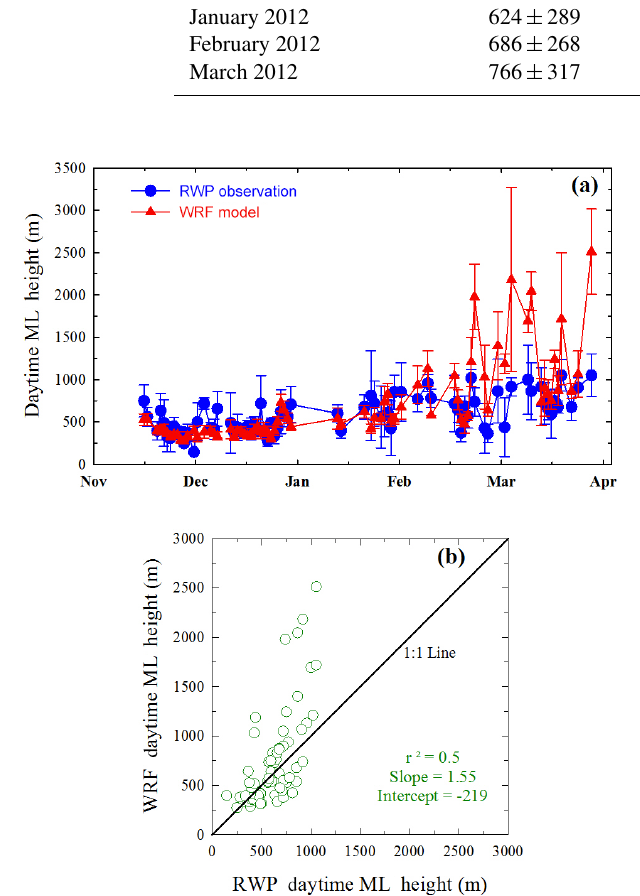
Figure 7. (a) A comparison of daytime (05:00–10:00UTC) average boundary layer height from RWP measurements and WRF simula- tions at Nainital during the study period. Error bars represent 1 σ standard deviation during daytime. (b) Correlation analysis between observational and model daytime boundary layer height. A 1:1 line is also